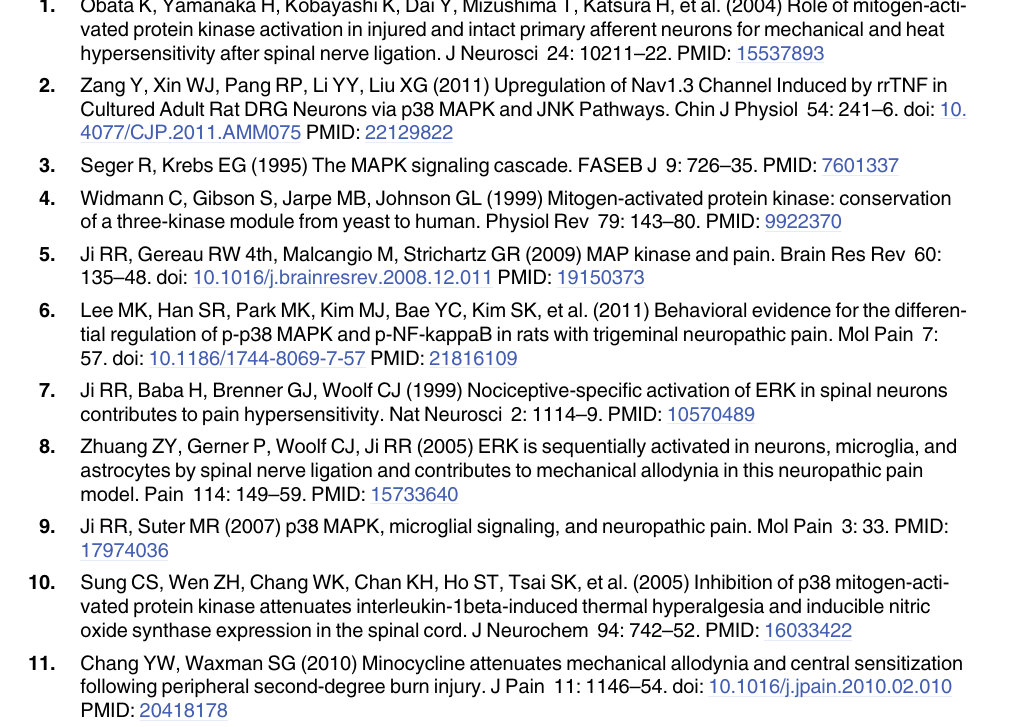
S1 Table. Drug used in the study. S2 Table. Primers used in the study. S3 Table. Antibodies used in the